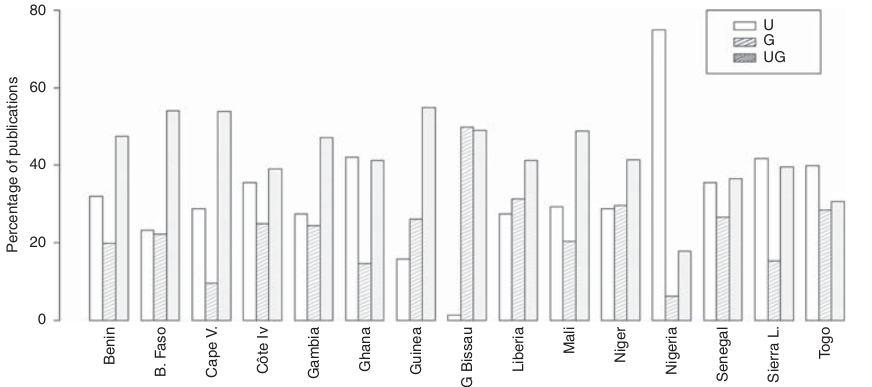
Figure 2. Outputs of the